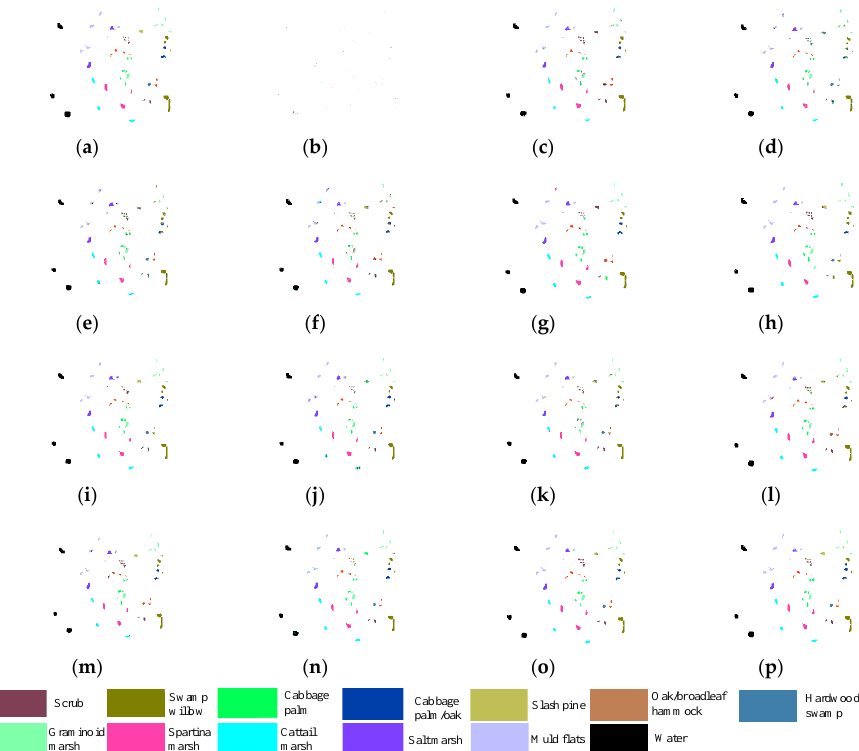
Figure 10. Classification maps of different methods on the Salinas Valley dataset ( a ) Ground; ( b ) Training; ( c ) SVM, OA = 82.45%; ( d ) PCA-SVM, OA = 79.49%; ( e ) LDM, OA = 85.11%; ( f ) PCA-LDM, OA = 80.65%; ( g ) EPF, OA = 89.03%; ( h ) IFRF, OA = 86.21%; ( i ) PCA-EPFs, OA = 94.12%; ( j ) LDM-FL, OA = 90.17%; ( k ) CF-SVM, OA = 90.07%; ( l ) CF-LDM, OA = 91.02%; ( m ) DTRF-SVM, OA = 92.62%; ( n ) DTRF-LDM, OA = 95.24%; ( o ) CFDTRFF-SVM, OA = 95.89%; ( p ) CFDTRF-LDM, OA = 97.33%. Table 5. Comparison of classification accuracies (in percent) provided by seven methods for Kennedy Space Center (part A).